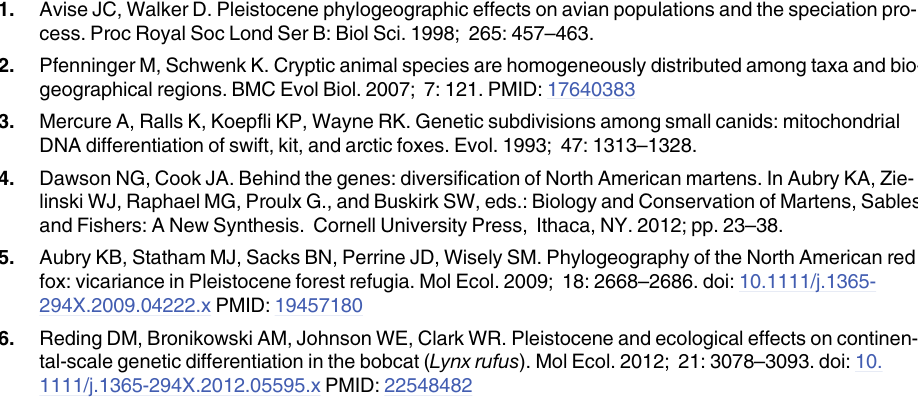
S2 Fig. Median-joining network of 785-bp composite cytochrome b and D loop haplotypes from Hofman et al. [17] superimposed on the network structure from the present study. Inset shows magnified copy of island fox haplotypes color-coded in terms of island where sam- pled as per the adjacent legend. Nodes are approximately proportional to samples size in both figures. GenBank accession numbers for Hofman et al. [17] haplotypes were KP128924- KP129108. (TIF) S3 Fig. Bayesian skyline plot of 27 western gray fox whole mitogenomes from Hofman et al. [17], illustrating mid- to late-Holocene decline. The black line represents the median population size, while the lines above and below represent the 95% highest posterior density (HPD). Dashed lines indicate glacial-interglacial boundaries and the blue shaded rectangle indicates the last glacial maximum (LGM) for reference to the population sizes. (TIF) S4 Fig. Reconstruction of the network of Hofman et al. [17] from their 185 western Uro- cyon whole mitogenomes (GenBank accession Nos. KP128924-KP129108), in particular illustrating 159 island fox haplotypes and associated rho estimates (and standard devia- tions). Rho estimates were translated to ages in years assuming a 2-year generation time and substitution rates of 2.8% per million generations in coding DNA and 17.75% per million gen- erations in noncoding DNA (see main text for additional explanation). The small white node corresponds to gray foxes from northern California.